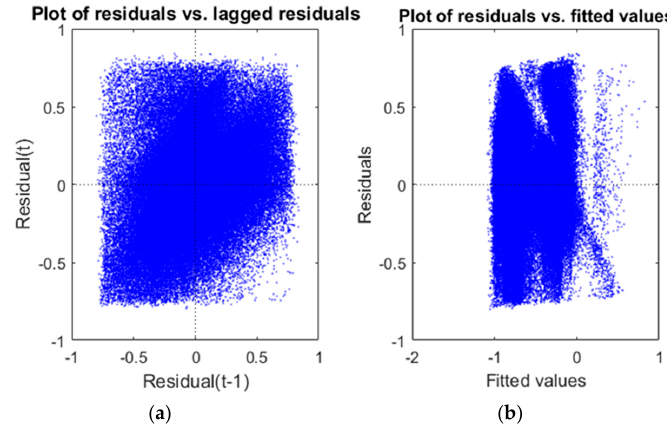
Figure 9. Scatter plot of residuals. ( a ) Residuals versus lagged residuals. ( b ) Residuals versus fitted values.